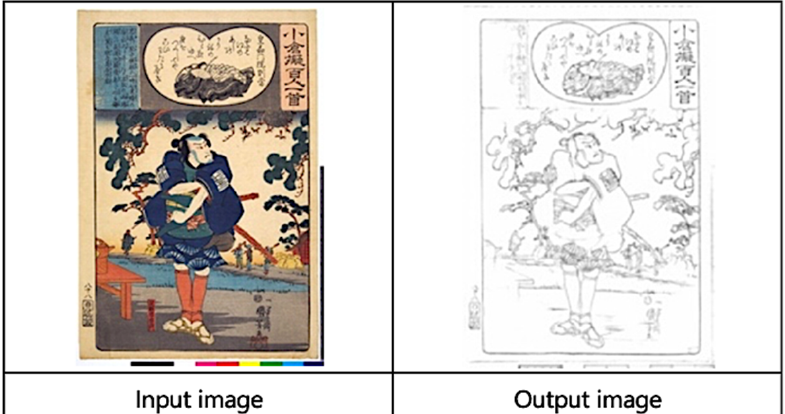
Figure 7. Example sketch image output from AODA Net. Original input image is extracted from the ukiyo-e prints series Ogura Imitations of One Hundred Poems by One Hundred Poets ( 小倉擬百人一首 ).